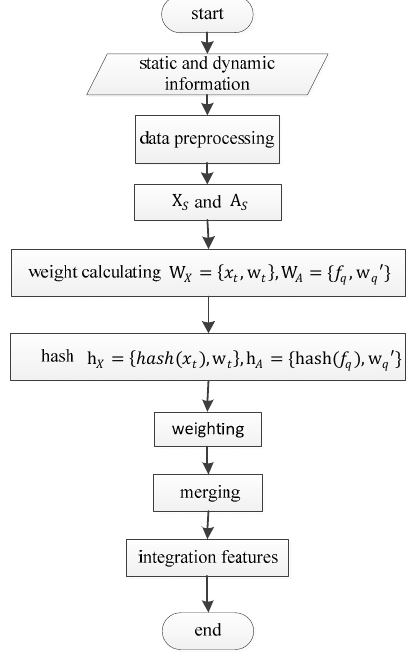
Figure 3. Integrative feature extraction.